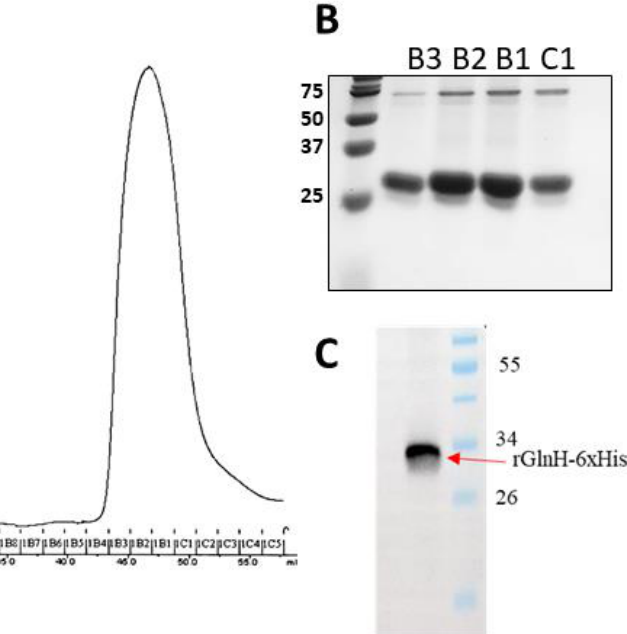
Figure 4. ( A ) Timeline of vaccination schedule, indicating days of immunisation, challenge and or- gan collection. Mice were immunised three times with 10 or 50 µg recombinant GlnH antigen with alum as adjuvant. ( B ) Serological analysis of responses to GlnH immunisation in mice. Sera were obtained by blood collection seven days after third immunisation dose, serially diluted and anti- body titres determined by ELISA using antigen-specific antibodies and antibodies specific for mouse IgGs. Data are reported as the OD obtained at each dilution. ( C ) Faecal shedding was moni- tored daily to access protection conferred against E. coli O157 NCTC Nal r 6 days post-challenge. The daily E. coli O157 shed from mice faeces (pooled per cage) are represented as mean CFU ± SD of two independent faecal collections from each group. Significant differences in daily NCTC12900Nal r shed between groups were determined via two- way ANOVA Tukey’s multiple comparison test (*, p < 0.05). ( D ) Colonisation of colon (white bars) and caecum (grey bars) at day 7 post-challenge with 4 × 10 9 CFU with E. coli prototype strain NCTC 12900 Nal r ; the colon and caecum were collected from each mouse after euthanasia. Bacterial burden was determined per gram of tissue, and level of colonisation was expressed in log scale. All colonisation data are displayed as means ± SEM of re- sults obtained per treatment group. No statistical significance was observed by analysis using a one- way ANOVA with Sidak’s multiple comparison test between immunised and non -immunized groups. ( E ) Weight gain in immunised mice relative to control mice over 7 days post challenge. Data are normalised relative to individual mouse weight. GlnH-/Alum-immunised mice challenged with the NCTC12900Nal r O157 prototype strain showed modest protection from E. coli O157:H7, as shown by reduced faecal shed- ding on day 6 p.i. (Figure 4C, p < 0.0218) and reduced area under the curve overall (29.6 versus 25.6 CFU days/g tissue, for Alum- and GlnH-immunised, respectively. However, GlnH/Alum failed to protect mice from colonisation (Figure 4D). Despite a lack of change in faecal shedding, the immunised mice gained more weight post-challenge relative to the alum control group (Figure 4E, p = 0.0296), suggestive of better wellbeing. Cellular im- mune responses are involved in protection against VTEC; consequently, we examined whether an adjuvant that stimulated T-cell activation would enhance E. coli O157Nal r pro- tection over robust antibody production. We chose the T-cell-stimulating adjuvant, SAS, which comprises monophosphoryl lipid A and trehalose dimycolate [35]. Mice immun- ised s.c. with 10 µg GlnH in combination with either SAS (1:1) or alum (1:1) were com- pared to mice treated with either adjuvant alone. The GlnH protein was again confirmed as a highly immunogenic B-cell antigen, with strong antibody titres following immunisa- tion with 10 µg rGlnH regardless of the adjuvant (Log 10 6.97, Figure 5A), indicating that